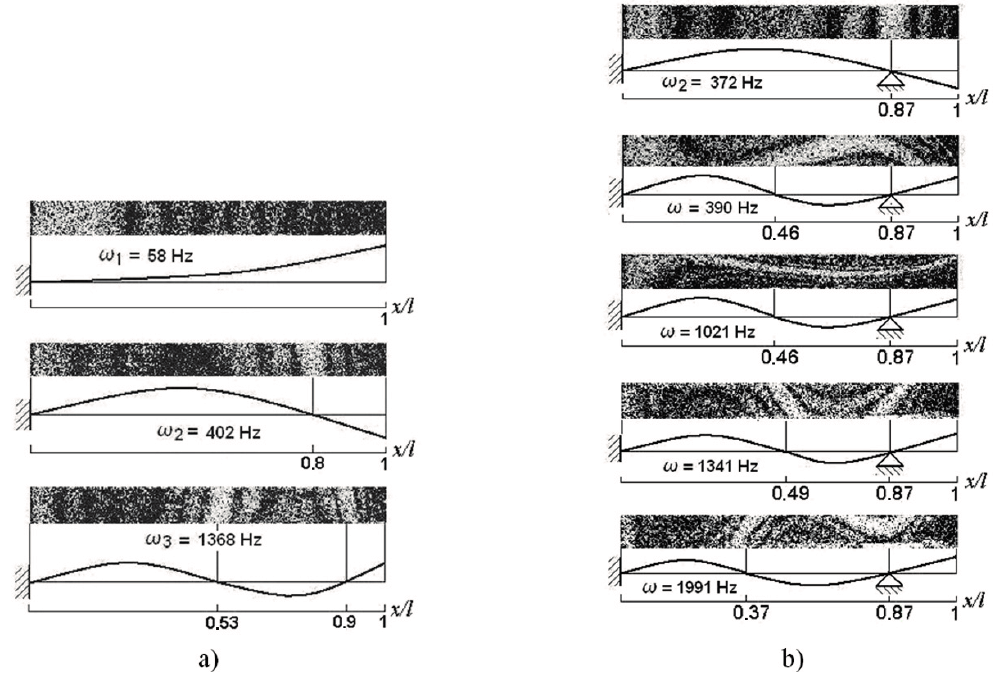
Figure 19. Optimally configured cantilever: natural vibration modes and frequencies: ( a ) unsupported; ( b ) rigid support at ( x / l = 0.87); ω 1 –I mode; ω 2 –II mode; ω 3 –III